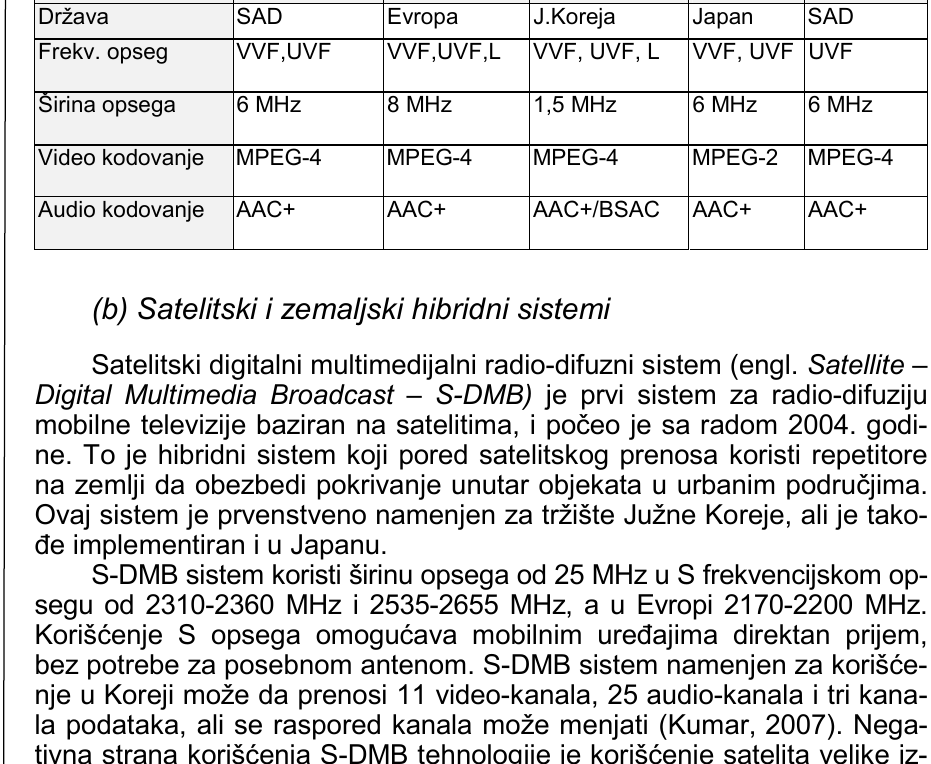
Tabela 2 – Osnovni parametri radio-difuznih tehnologija za mobilnu televiziju Table 2 – Basic parameters of broadcast technologies for mobile television